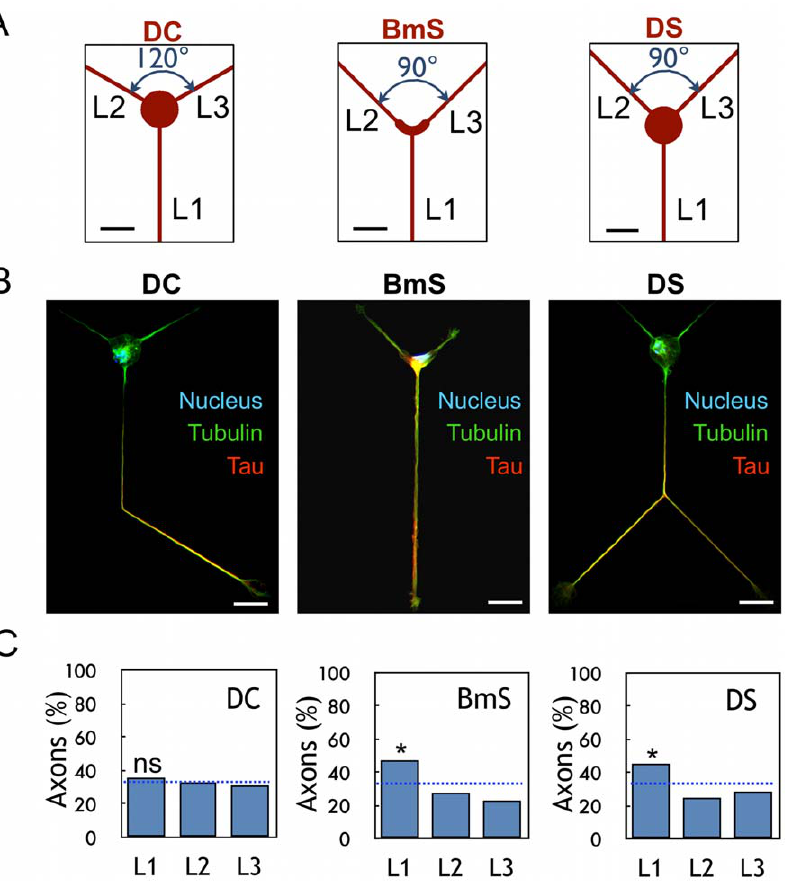
Figure 1. Effect of soma constraints on axonal polarization. (A) Design of patterns DC, BmS, and DS; L1–L3 directions are indicated. (B) Immunolabelings of stage 3 neurons on DC, BmS and DS patterns: axon (tau staining, red), microtubules (tubulin staining, green) and nuclei (Hoechst staining, blue). The shape of the cells reflects the global organization of DC/DS patterns in a hexagonal network. Scale bar, 20 m m. (C) Results of axonal polarization, i.e. percentages of stage 3 neurons with their axon along L1–L3 directions ( n =194, 176 and 267 for the DC, BmS and DS patterns, respectively). *, significantly different from random (blue dotted line, 33.3% in each direction), p , 0.05.